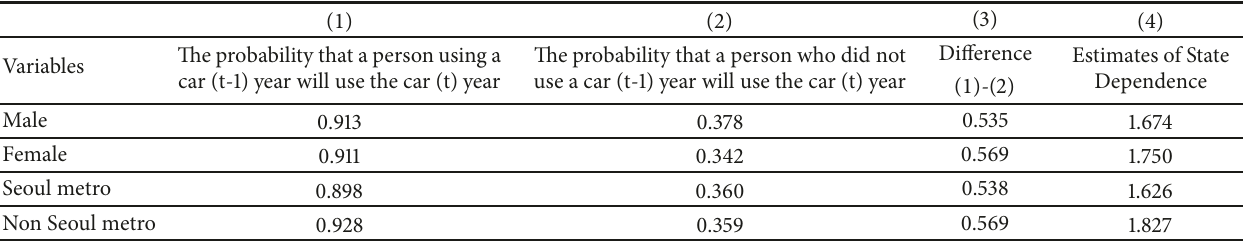
Table 9: Estimation of state dependence of passenger car